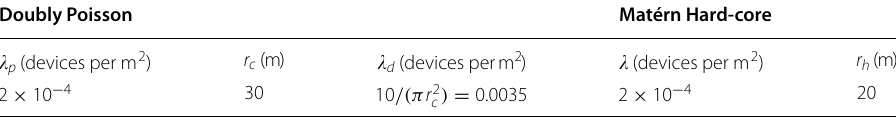
Table 1 Parameters for doubly Poisson point process and Matérn hard‑core process point process Doubly Poisson Matérn